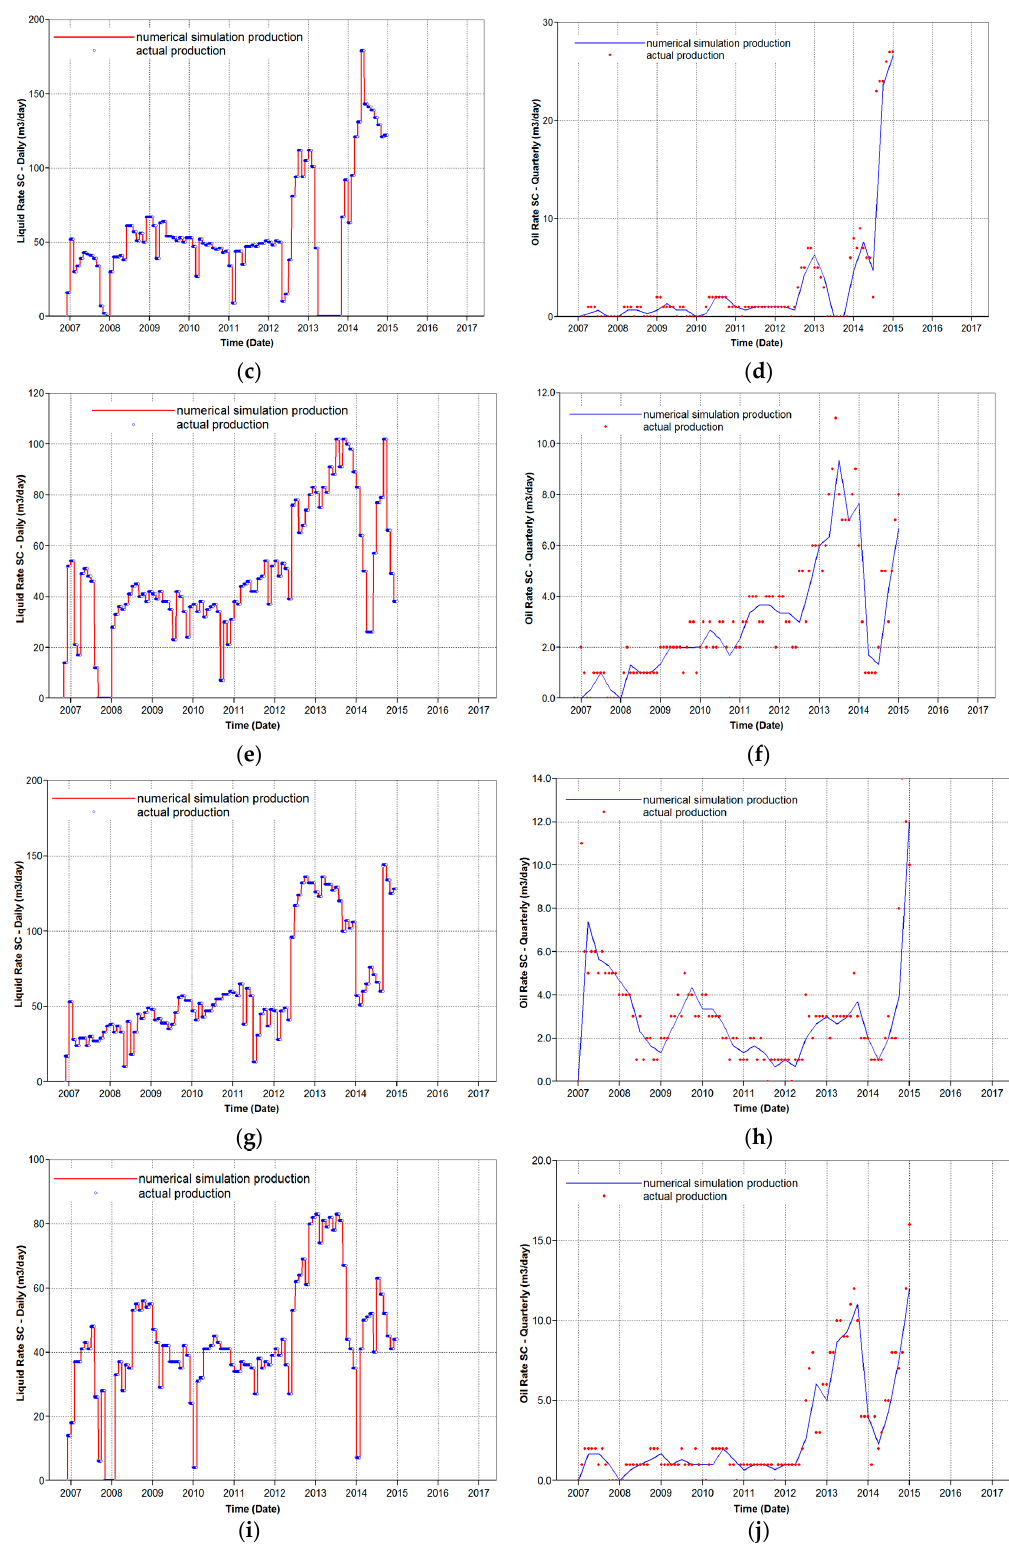
Figure 5. Fitting curve of the monthly liquid and oil production of a single well. ( a ) Liquid production of the CD208-SP10 well; ( b ) CD208-SP10 well; ( c ) liquid production of the CD8-SP07 well; ( d ) oil production of the CD8-SP07 well; ( e ) liquid production of the C208-SP010 well; ( f ) oil production of the C208-SP010 well; ( g ) liquid production of the C8-SP012 well; ( h ) oil production of the C8-SP012 well; ( i ) liquid production of the CP208-SP11 well; and ( j ) oil production of the CD208-SP11